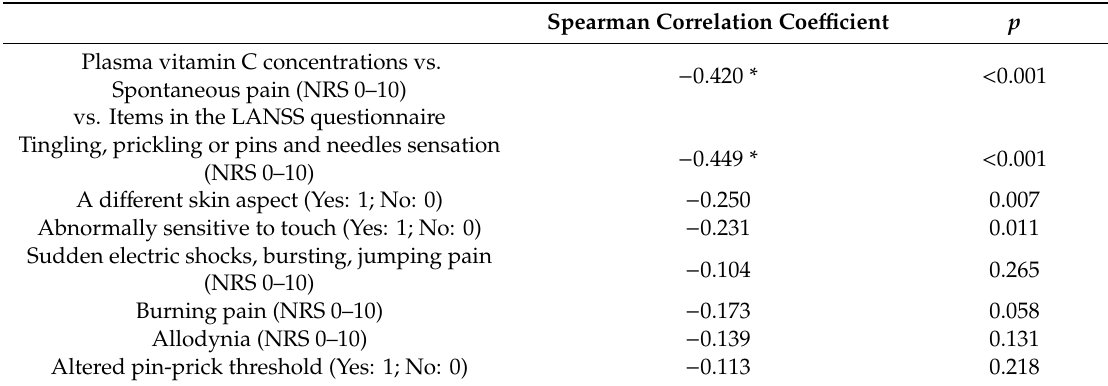
Table 2. Correlations between plasma vitamin C concentrations and spontaneous pain / items in the LANSS questionnaire among PHN patients.